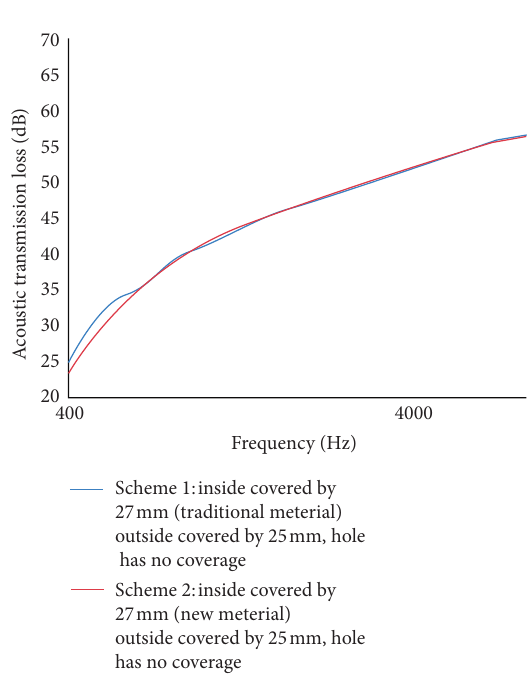
Figure 12: Compared curve of sound insulation performance.